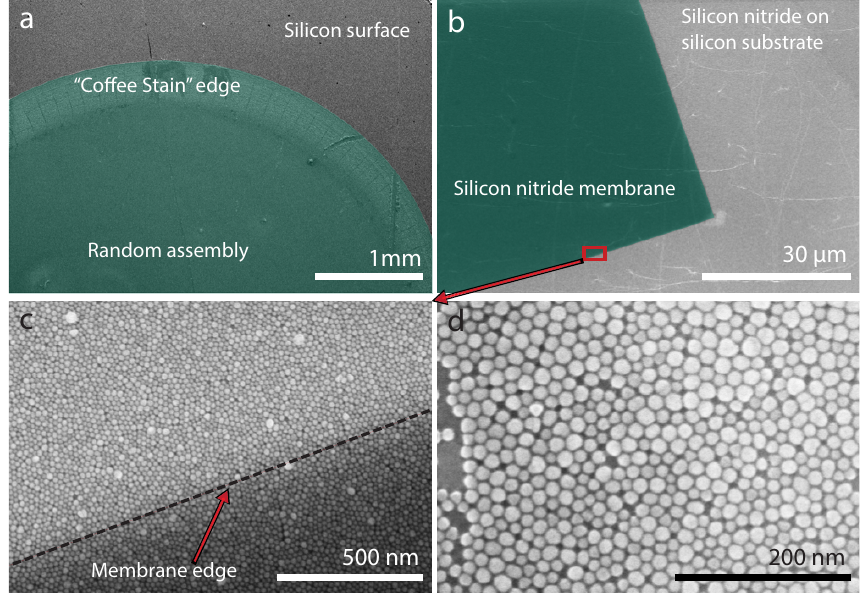
Figure 1. SEM images of self-assembly of nanoparticles. ( a ) Green color (false-color) represents the nanoparticle deposition on the silicon surface. ( b ) Nanoparticle self-assembly on a large scale; green color (false-color) shows the silicon nitride window ( c ) Magnified view of the edge of the silicon nitride window from ( b ) with the nanoparticle assembly ( d ) Magnified view of the close packed nanoparticle distribution in the